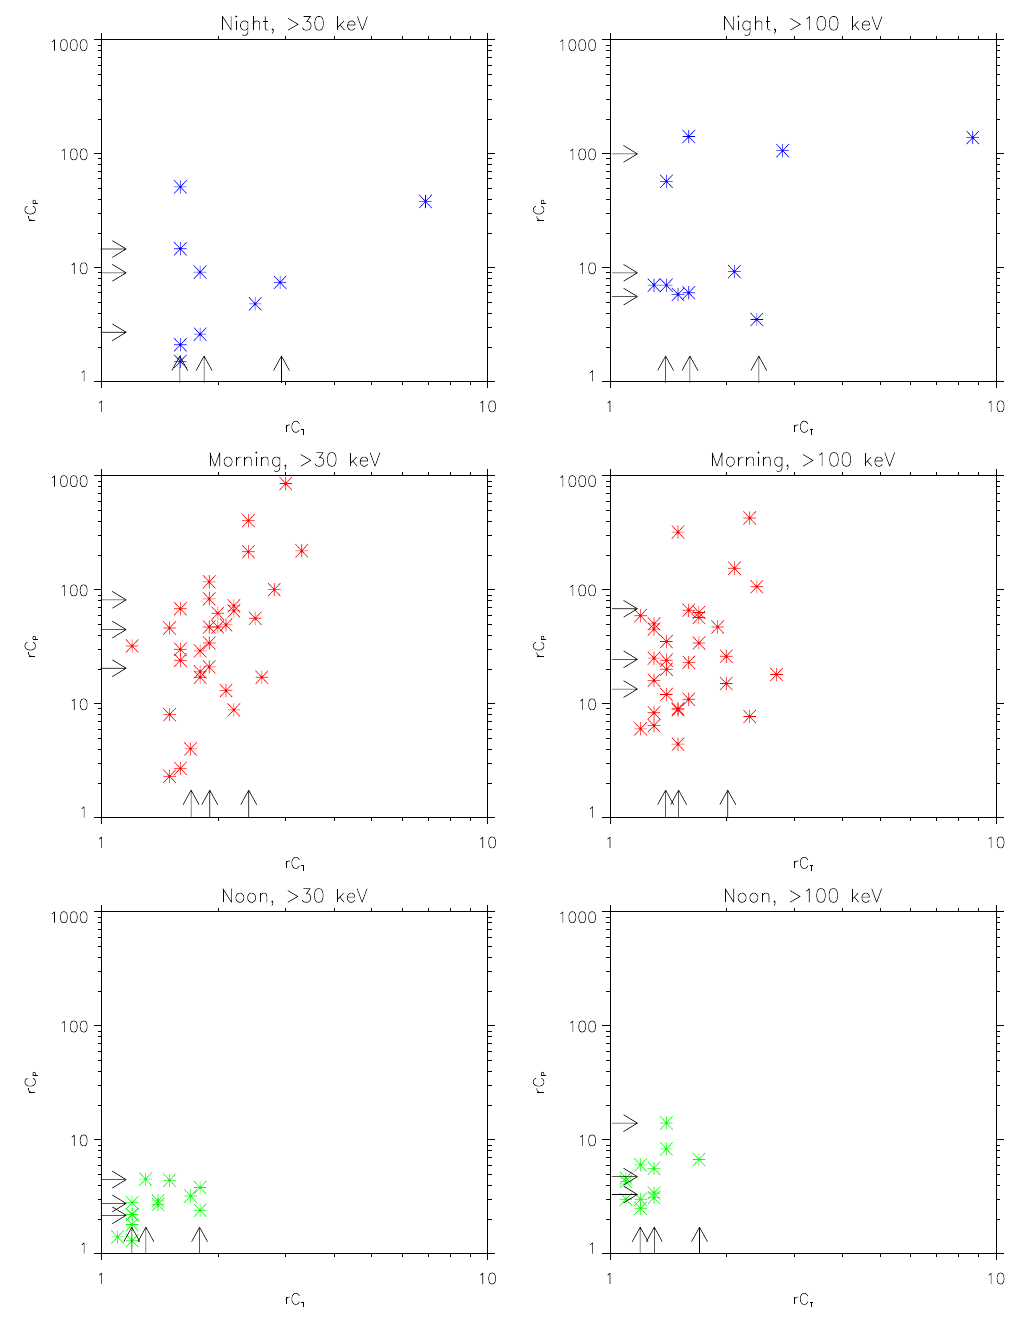
Figure 2: Statistics of the maximum point-to-point change of precipitated (rC P ) against trapped (rC T ) flux Fig. 2. Statistics of the maximum point-to-point change of precipitated ( rC P ) against trapped ( rC T ) flux observed during each overpass, observed during each overpass, expressed as ratios, for ‘night’ ( expressed as ratios, for “night” ( ∼ 02:30LT), “morning” ( ∼ 08:30LT) and “noon” ( ∼ 12:30LT) sectors. (The arrows mark the medians and ( 12:30 LT) sectors. (The arrows mark the medians and quartiles.) ∼